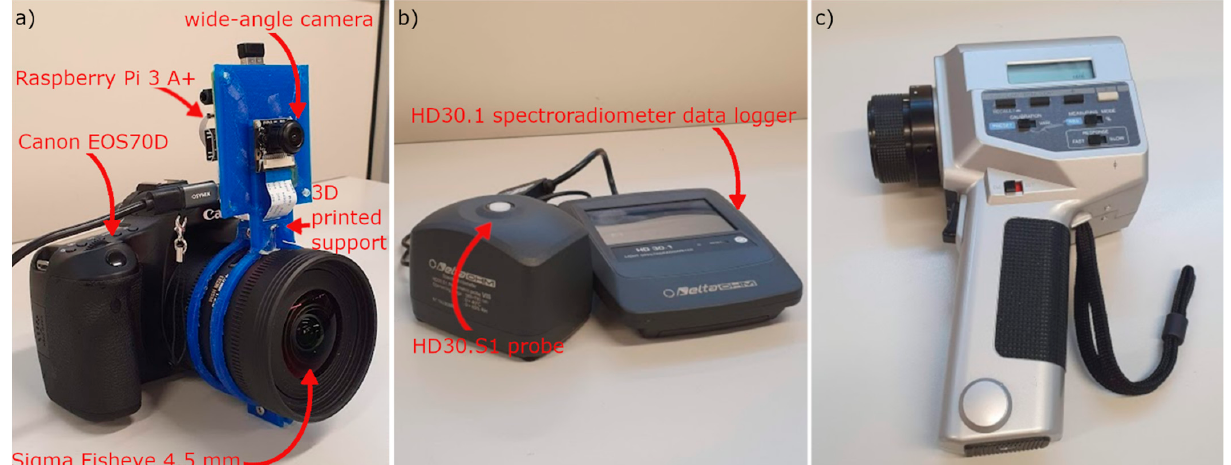
Figure 3. Equipment used: ( a ) reference camera photometer and low-cost Raspberry Pi with a wide- angle camera mounted on the 3D printed support; ( b ) spectroradiometer and light probe; ( c ) Konica